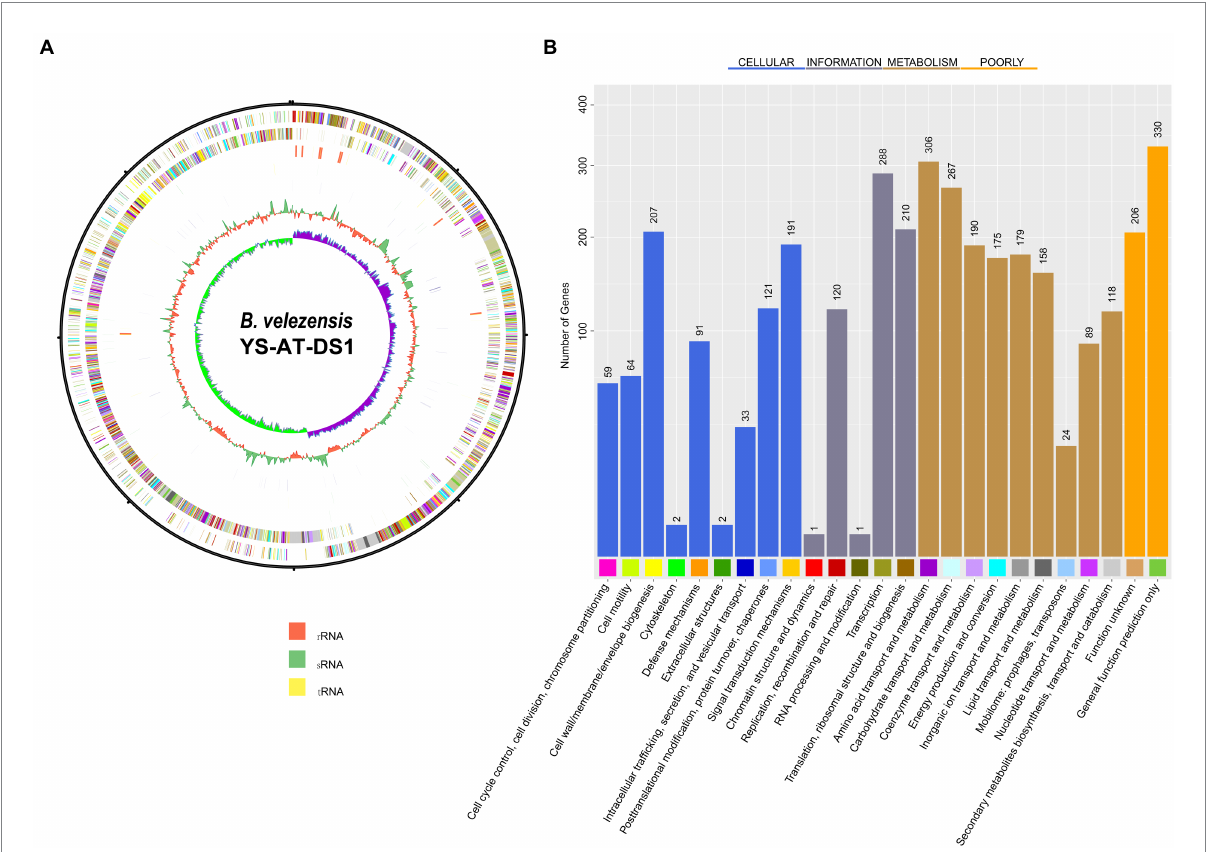
FIGURE 2 (A) Graphical circular map of Bacillus velezensis YS-AT-DS1 chromosome. From outer circle to the centre: CDS on forward strand (coloured according to COG categories), all CDS and RNA genes on forward strand, all CDS and RNA genes on reverse strand, CDS on reverse strand (coloured according to COG categories). The map was generated using Bacterial Annotation System, BASys. (B) COG functional